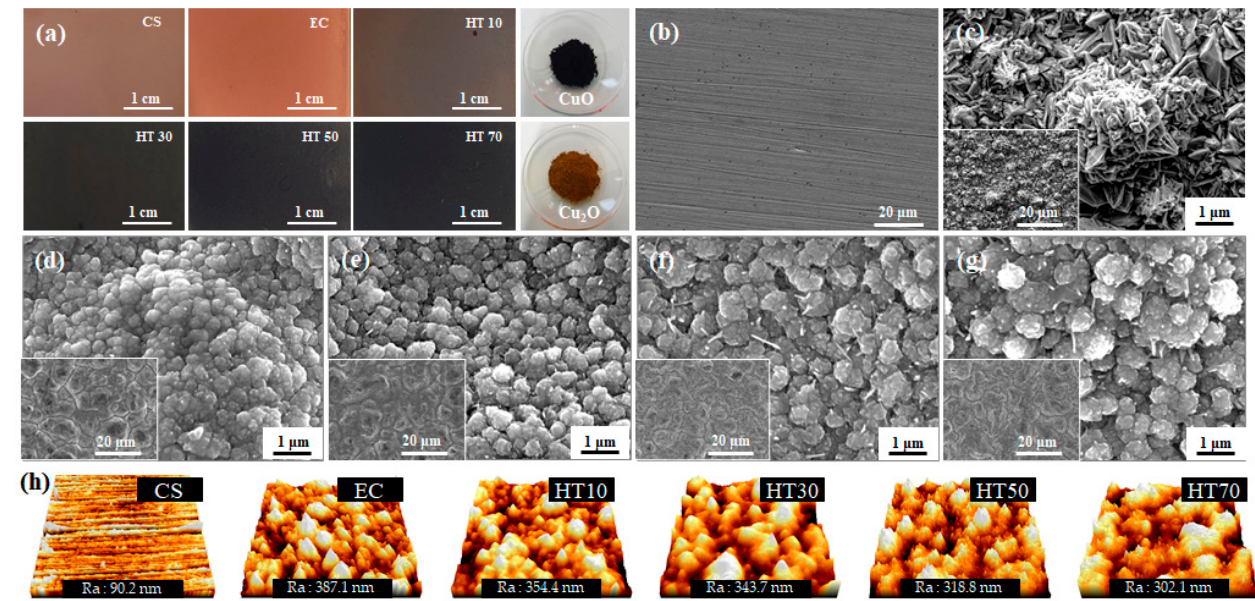
Figure 1. ( a ) Optical images of copper substrate (CS) and electrodeposited copper (EC) with heat treatment for 10 (HT10), 30 (HT30), 50 (HT50), and 70 (HT70) min. Surface SEM images of ( b ) CS, ( c ) EC, ( d ) HT10, ( e ) HT30, ( f ) HT50, and ( g ) HT70. ( h ) AFM images of sample surface and averaged roughness.